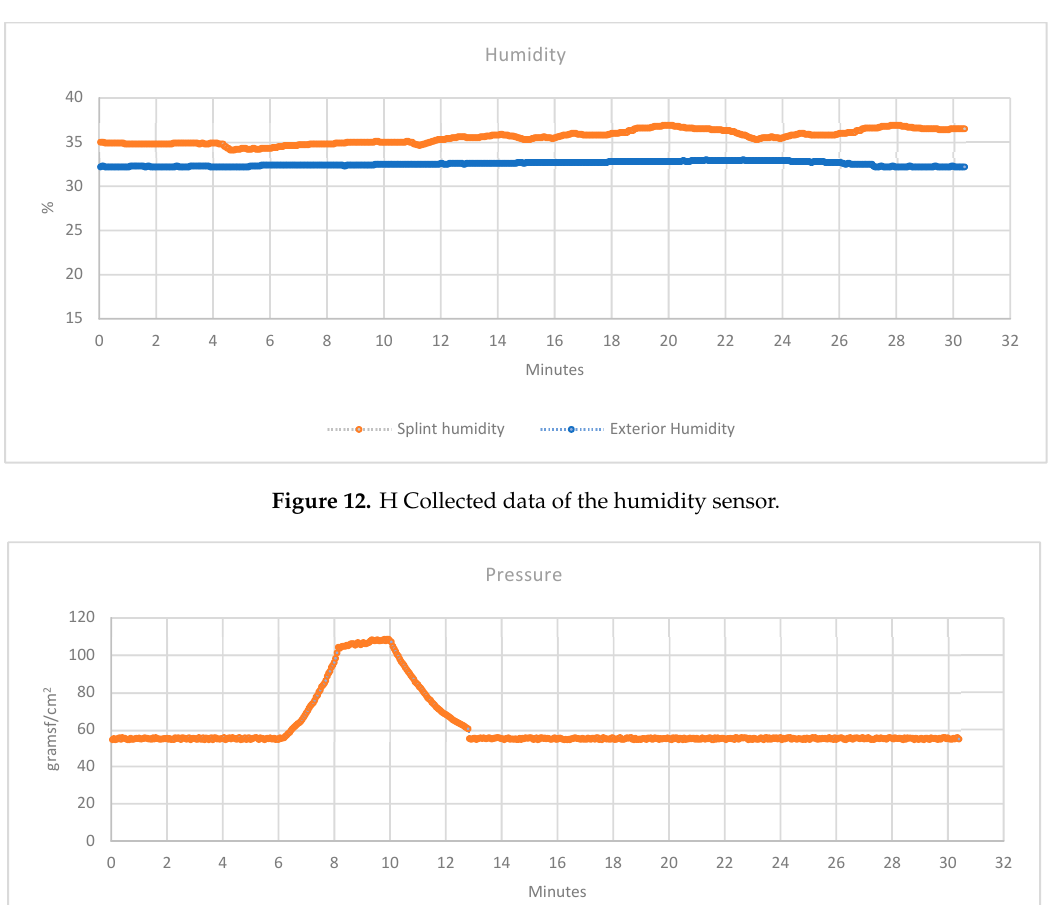
Figure 12. H Collected data of the humidity sensor.